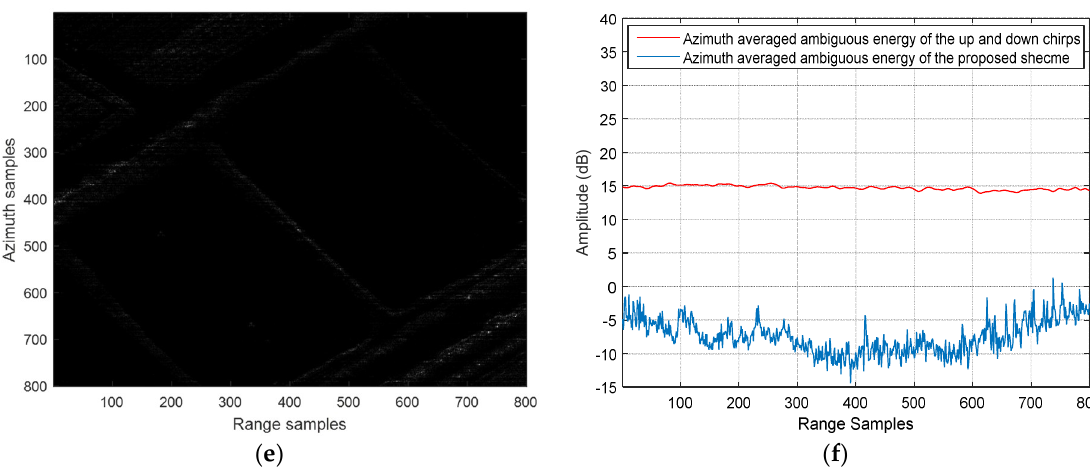
Figure 7. ( a ) Original scene. ( b ) MIMO-SAR image using the conventional up and down chirps. ( c ) MIMO-SAR image using the proposed echo-compression scheme. ( d ) The ambiguous energy in ( b ). ( e ) The ambiguous energy in ( c ). ( f ) The azimuth averaged ambiguous energy in ( d , e ).